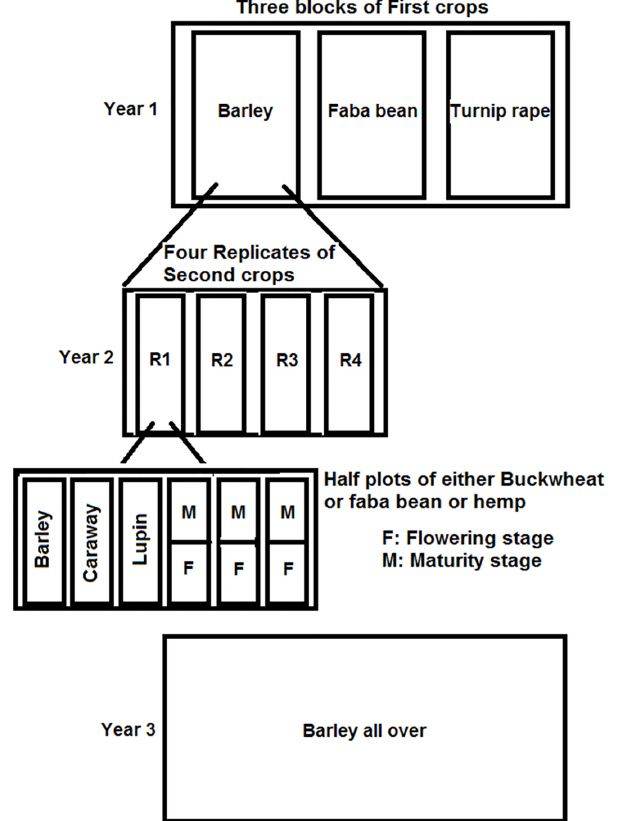
Fig 1. Field experimental setup. Barley, faba bean and turnip rape, as first crops, were grown in one block in the first year. In the second year, second crops were sown in randomized complete block designs with four replicates in each block of First crops. The whole plots of caraway and white lupin were incorporated into the soil at flowering stage, and the residues of the whole plots of barley were incorporated after harvest. Half plots of buckwheat, faba bean and hemp were incorporated into the soil at flowering stage and the residues of the other half were incorporated after harvest. In the third year, all the plots were sown with barley. The first year of site II coincided with the second year of site